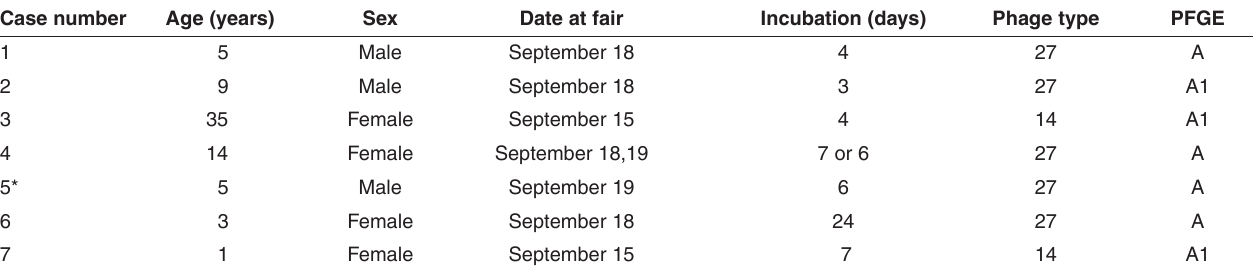
TABLE 1 Phage typing and pulsed-field gel electrophoresis (PFGE) results, laboratory confirmed cases of Escherichia coli O157:H7, Middlesex-London, Ontario,